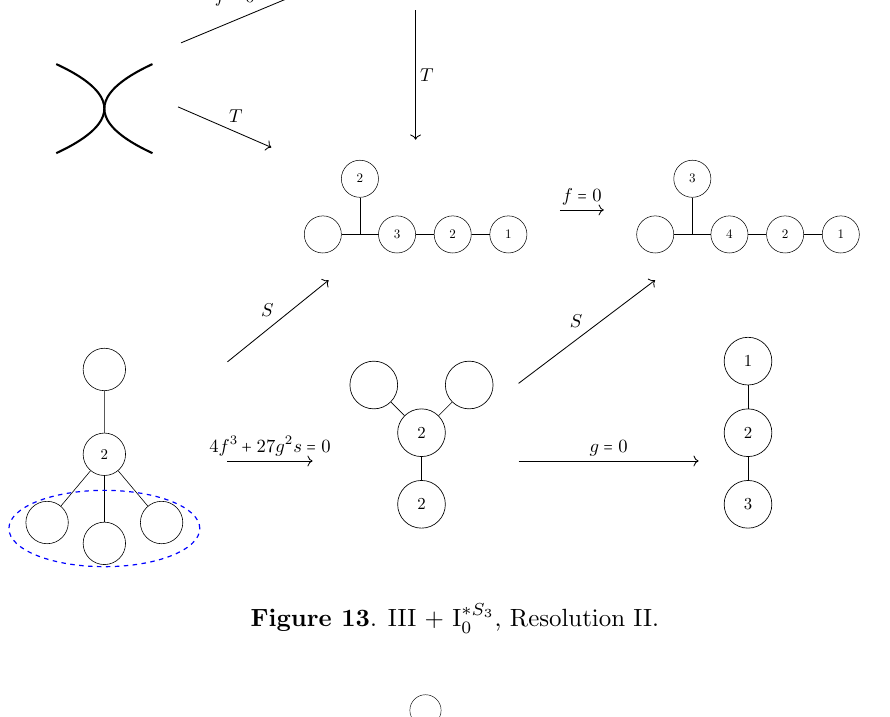
, Resolution II. 0